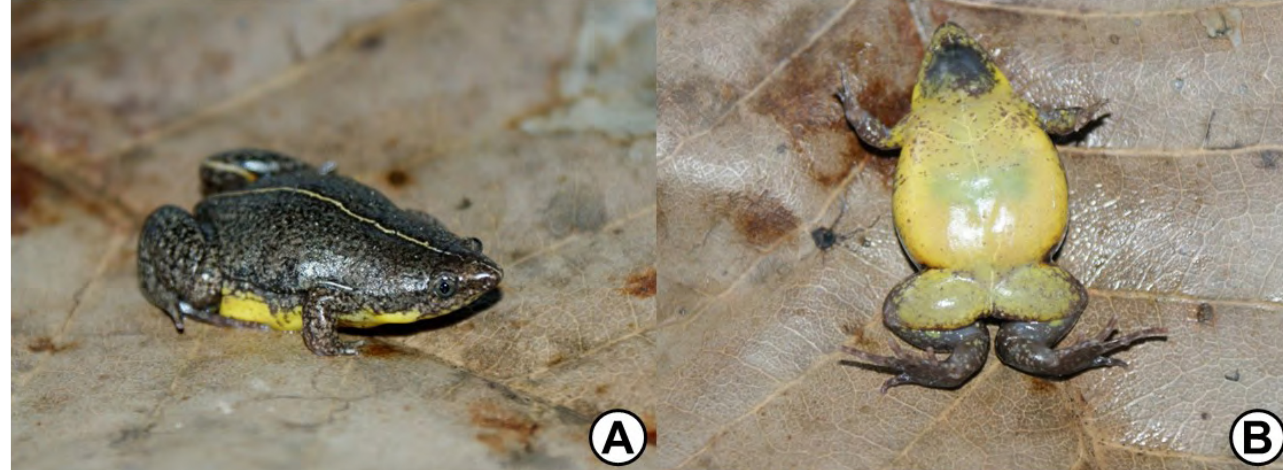
Figure 1. Elachistocleis helianneae from municipality of Macapá, state of Amapá, Brazil: ( A ) dorsolateral and ( B ) ventral color pattern of a live adult speci- men (male; SVL 27.2 mm) collected in May 2013 at Experimental Field of the Brazilian Agricultural Research Corporation/EMBRAPA, in Amazon